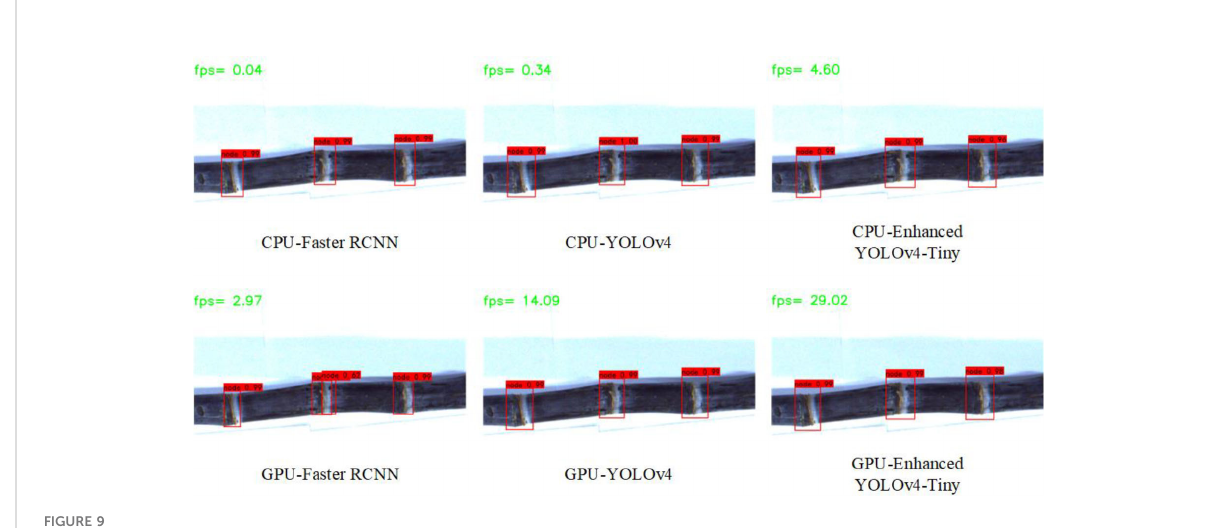
FIGURE 9 Recognition speed of sugarcane targets in different models under CPU and